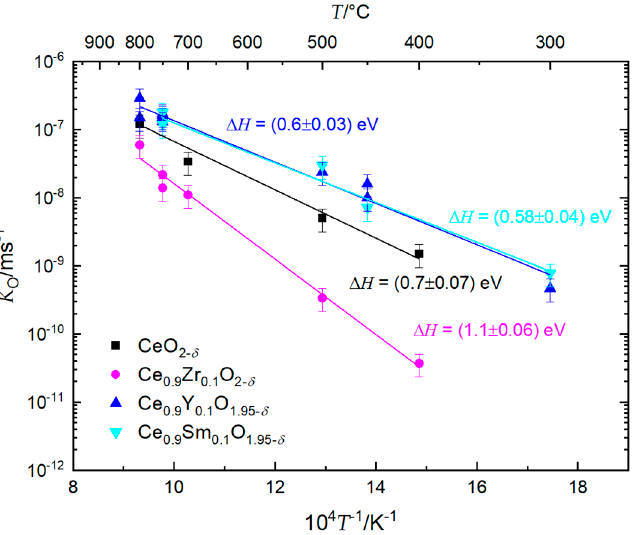
 K in ceria containing 10 at-% of do- O